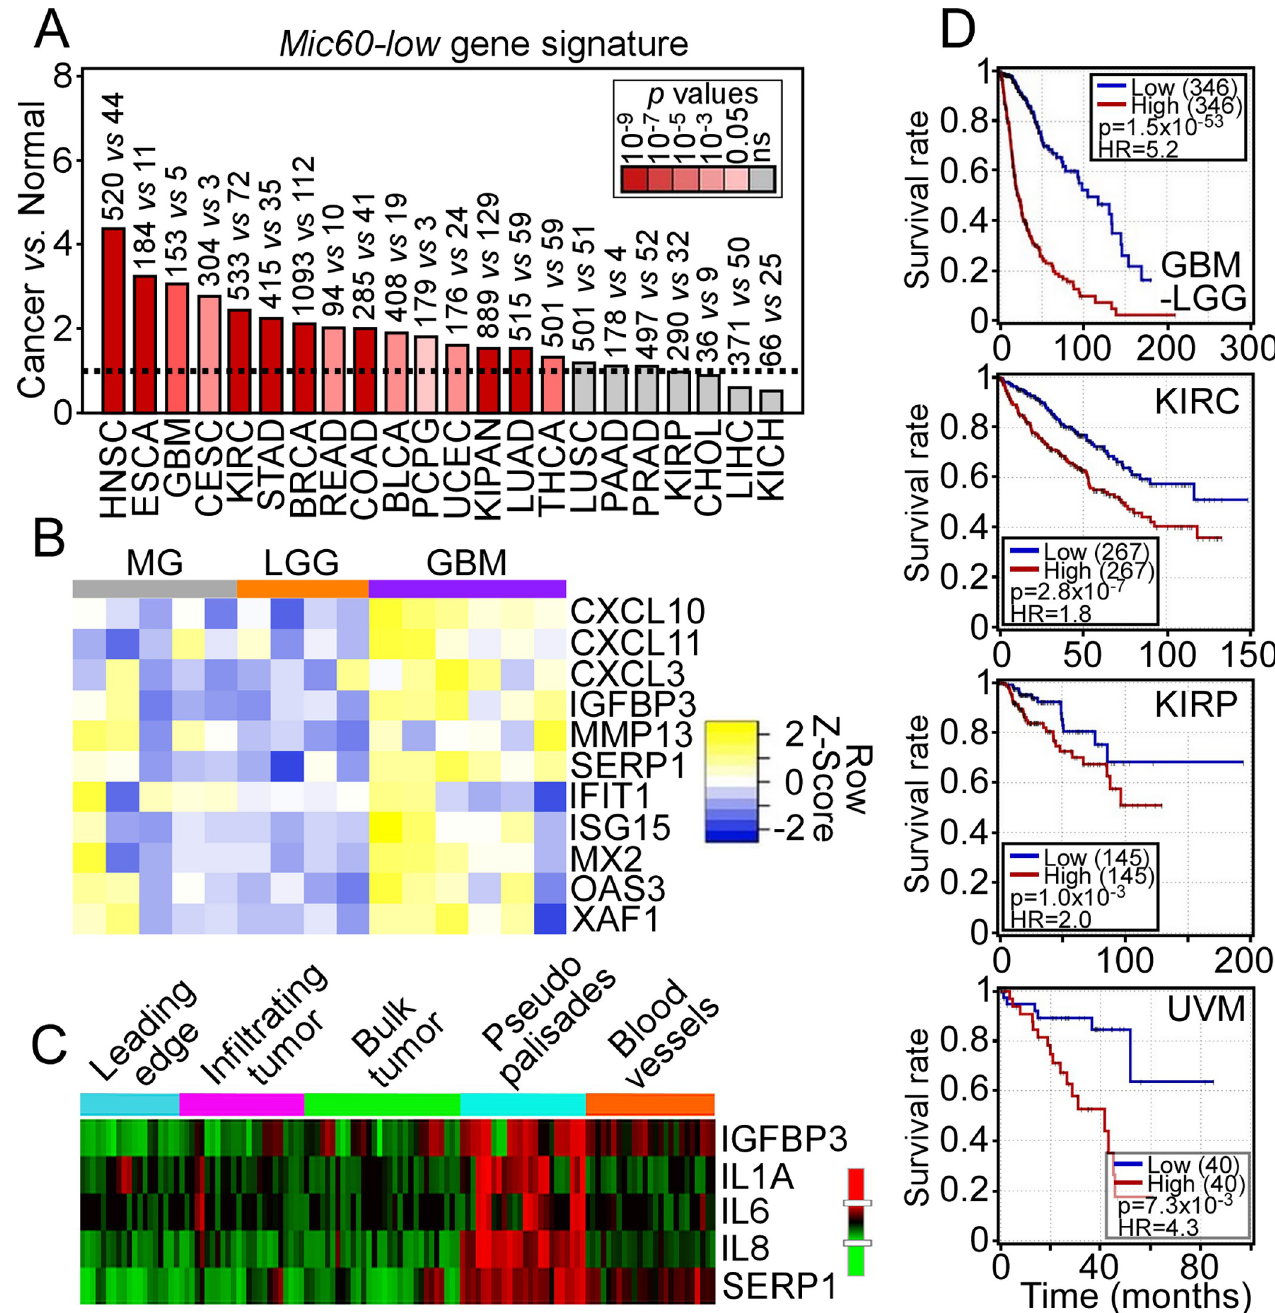
Fig 1. Differential expression of a Mic60-low gene signature in cancer. (A) TCGA tumor sets with RNA-seq data from matching normal tissues were examined for differential expression of the 11-gene Mic60-low gene signature in cancer vs . normal samples (ratio) by Wilcoxon rank-sum test. The number of tumor and normal tissue samples is indicated per each condition. Broken line, ratio of 1; red color scale, significance p value; ns, not significant. (B) Differential expression of the 11-gene Mic60-low gene signature in patient-derived tumor-free normal brain margins (MG), LGG or GBM by qPCR. The expression intensity of each gene is visualized in a heatmap. (C) The indicated representative genes in the Mic60-low gene signature were analyzed for spatial distribution in patient-derived GBM samples using the Ivy Glioblastoma Atlas Project dataset. The various GBM intratumoral compartments are indicated. (D) Kaplan- Meier survival curves of high vs . low expression of the Mic60-low gene signature in TCGA datasets of GBM-LGG, kidney renal clear cell carcinoma (KIRC), kidney renal papillary cell carcinoma (KIRP) and uveal melanoma (UVM). The number of patients per condition, p value and hazard ratio (HR) are indicated.